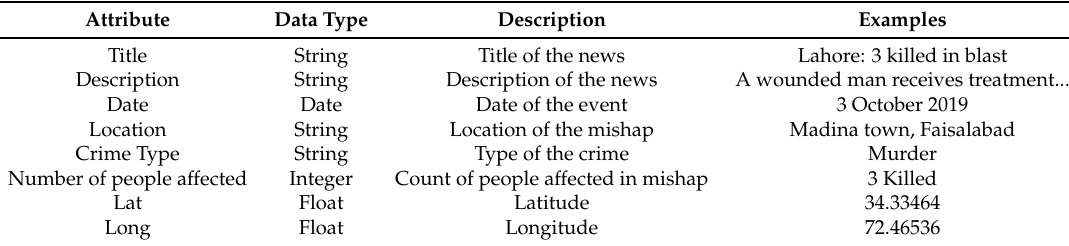
Table 3. Attributes of